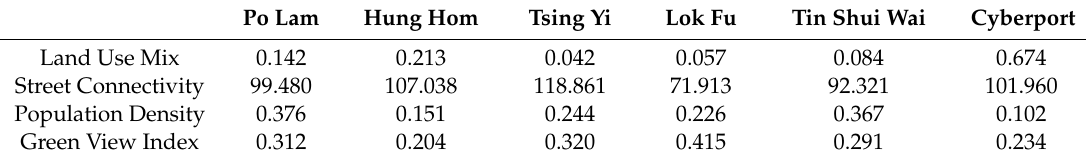
Table 3. Built environment characteristics and green view indexes of the six regions.